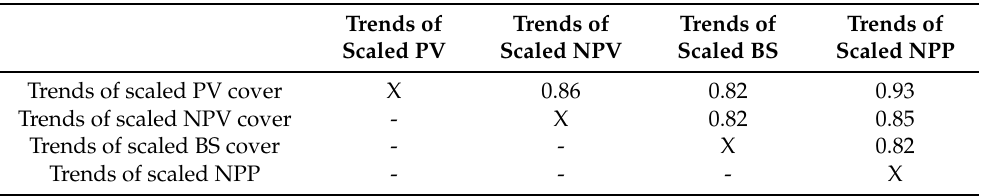
Table 8. Comparison of kappa values for maps of inter-annual trends in scaled components of fractional cover and inter-annual trends in scaled NPP in the Burdekin Dry Tropics. Comparisons were made with the fuzzy kappa statistic [47] applied to each pair of maps taken as a whole, hence the single value for each pair.